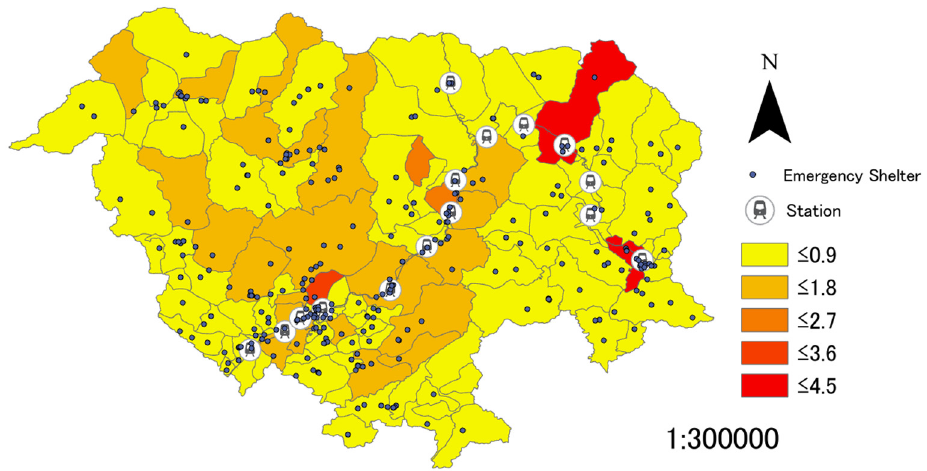
Figure 18. Result for Shobara City with the ratio of permanent population as a weighted coefficient.